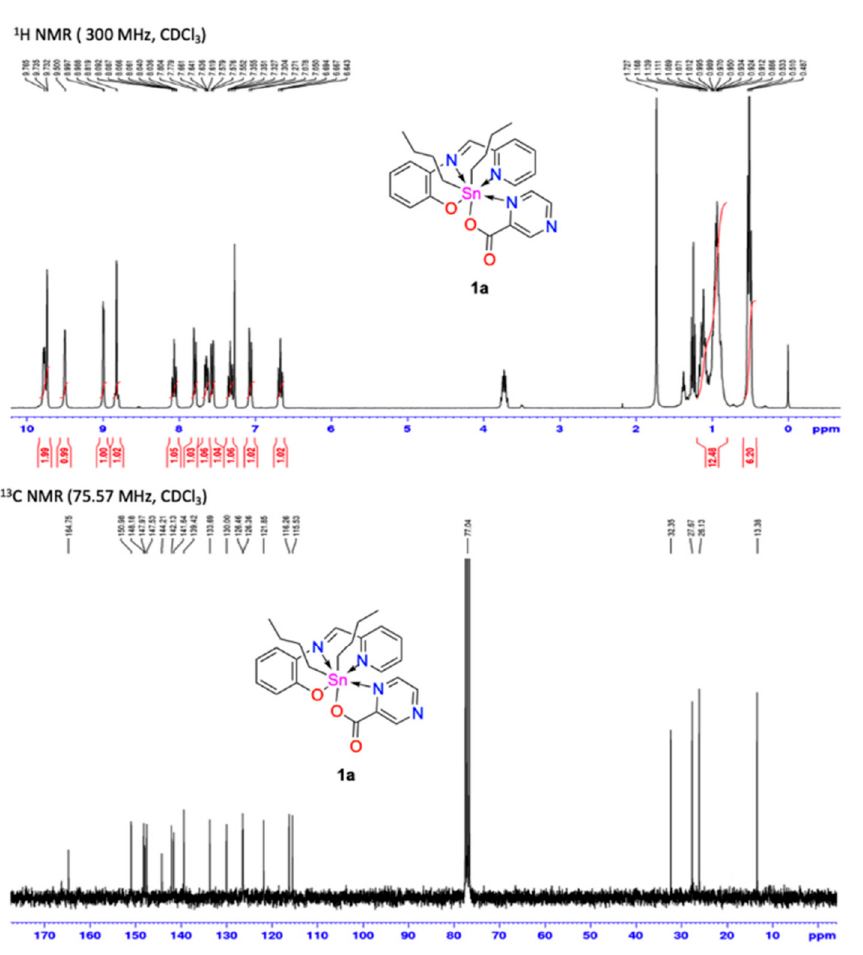
Figure 3. 1 H and 13 C NMR of complex 1a in CDCl 3 solution.